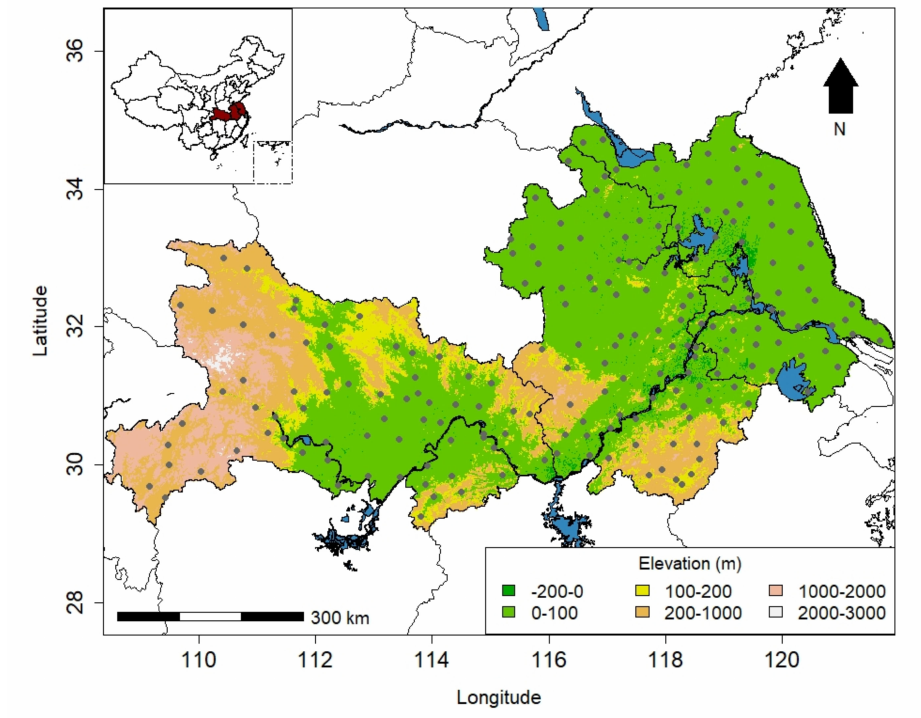
Figure 1. Topography and location of study area. Points indicate national ground meteorological